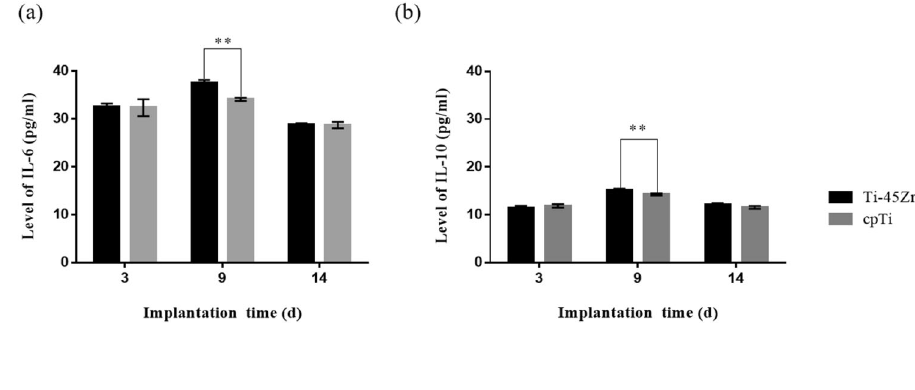
Fig. 7 HE staining histological observation of rats: neutrophils (red arrows); macrophages (green arrows); lymphocytes (yellow arrows); monocytes (black arrows); osteoblasts (orange arrows); osteoclasts (brown arrow); chondrocytes (blue arrows); fi brous tissue (gray oval); bone like matrix (blue square)